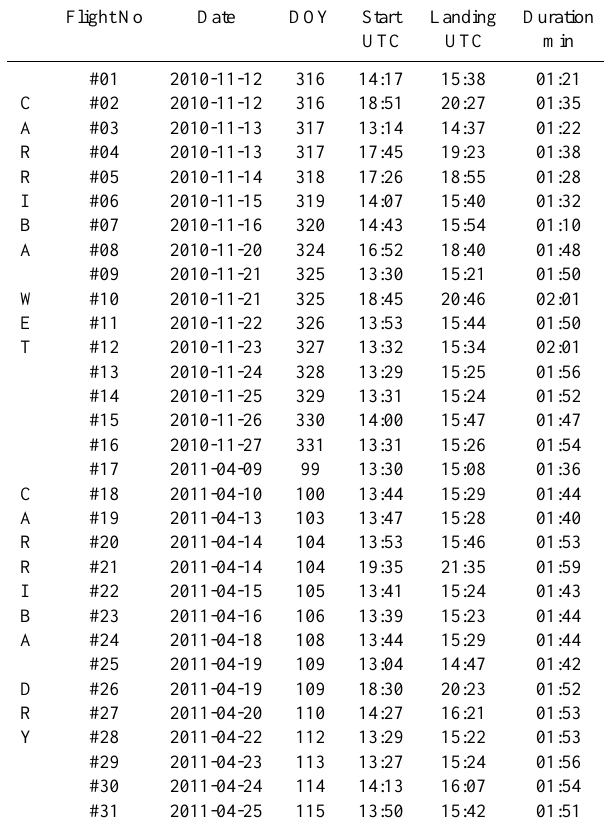
Table 1. Schedule of all research flights during CARRIBA WET in 2010 and CARRIBA DRY in